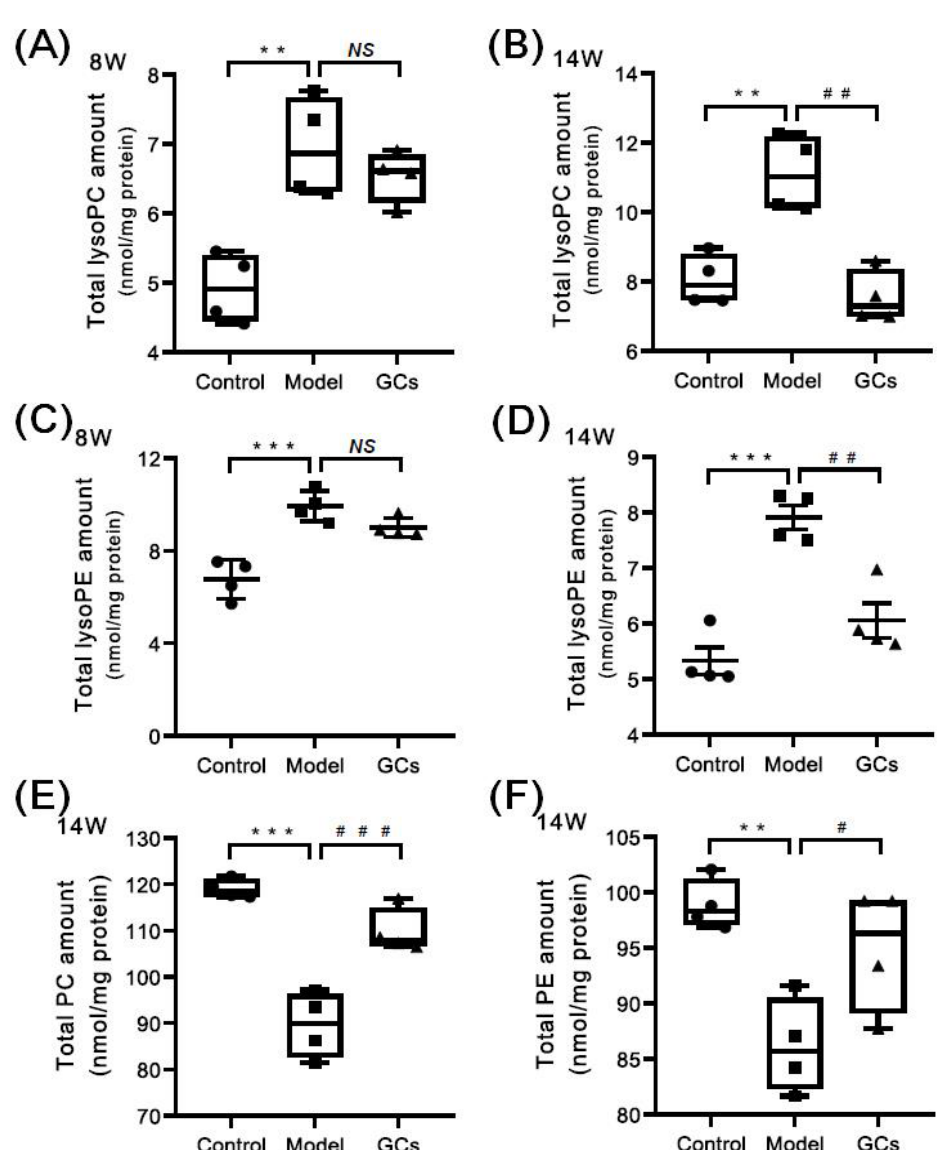
Figure 5. Comparison of the total amounts of lysophospholipid and phospholipid species in heart tissues from MRL/lpr mice from each group at different states. Heart tissues of the control ( n = 4), model ( n = 4), and GCs ( n = 4) groups were collected at 8 and 14 weeks of age, respectively. Both model and GCs groups were MRL/lpr mice, while the control group was MRL/MpJ mice. Lipidomics analysis of lysophospholipid species, including choline lysoglycerophospholipid (lysoPC) and ethanolamine lysoglycerophospholipid (lysoPE) (Panels A – D ), and phospholipid species, i.e., choline glycerophospholipid (PC) and ethanolamine glycerophospholipid (PE) (Panels E and F ), present in lipid extracts of heart was performed through multidimensional mass-spectrometry-based shotgun lipidomics. The data represent means ± SEM from different groups. Difference be- tween the groups was determined using ANOVA followed by Dunn multiple comparison with IBM SPSS Statistics 19 Software (SPSS Inc., Chicago, IL., USA) after the normality of each group of vari- ables was checked by Q–Q plots. The raw p values were adjusted to false discovery rat using the Benjamini–Hochberg method. **adjusted p < 0.01 and ***adjusted p < 0.001 compared with those in the control group. # adjusted p < 0.05, ## adjusted p < 0.01, and ### adjusted p < 0.001compared with those in the model group. NS , not significant.